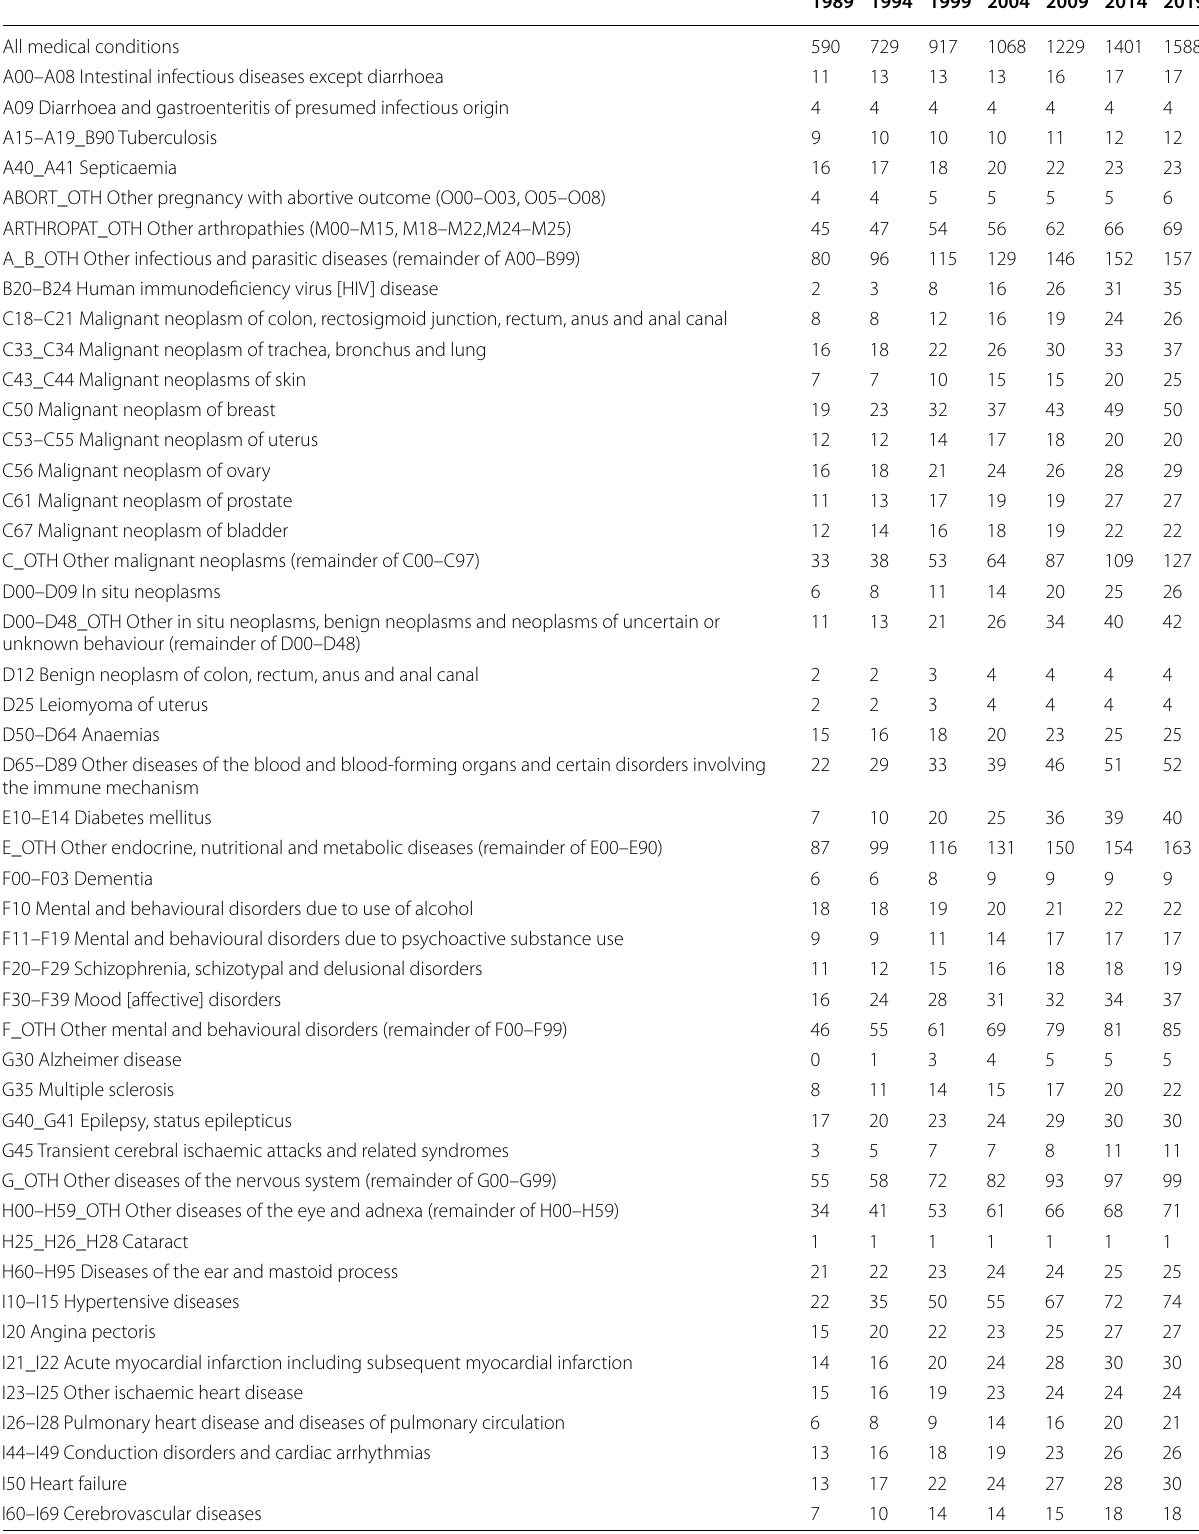
Table 7 No. of chemical substances ever registered in Switzerland, by medical condition (hospital classification),